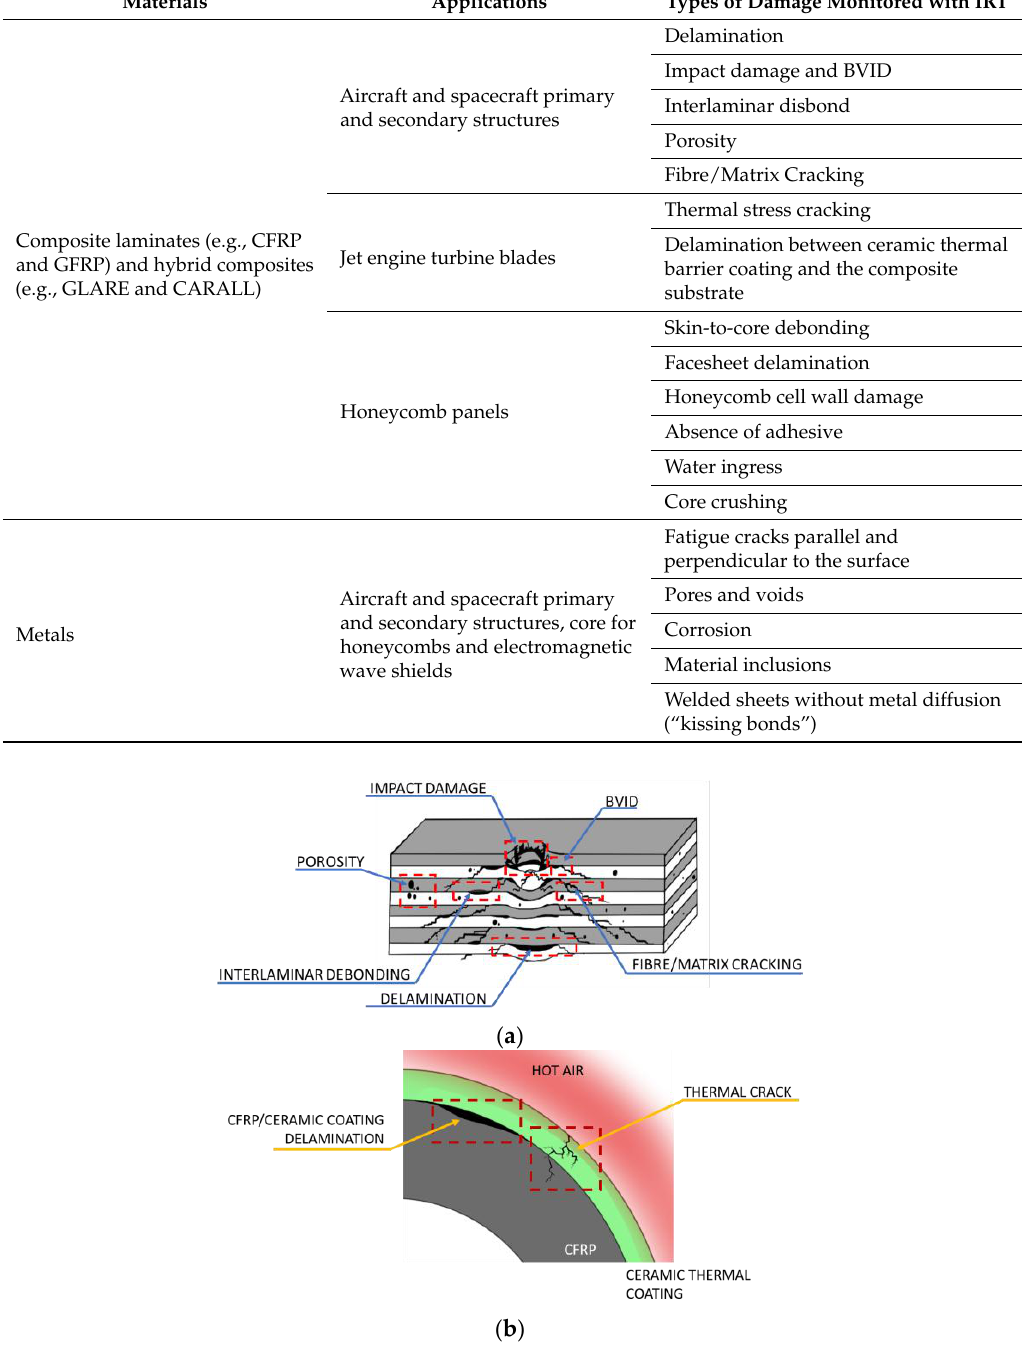
Table 1. Most common materials and types of damage used in aerospace components that are monitored with IRT.